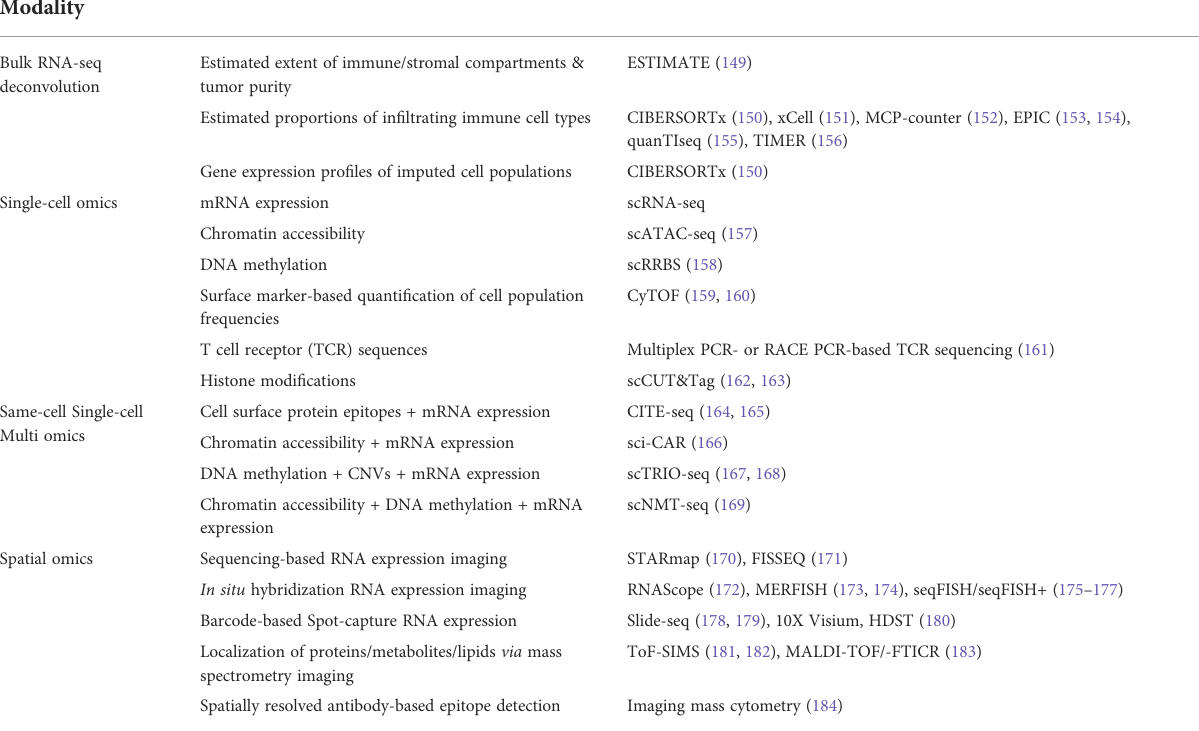
TABLE 2 Summary of cutting-edge technologies for cell-level resolution